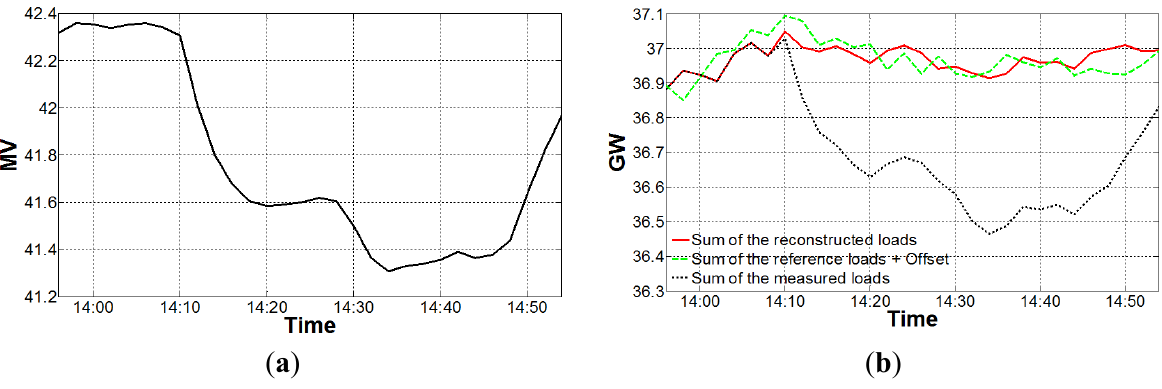
Figure 6. Results of the nationwide CVR implemented on 16 October 2012: ( a ) sum of 1837 bank voltages; and ( b ) sum of 1837 transformer-bank loads.